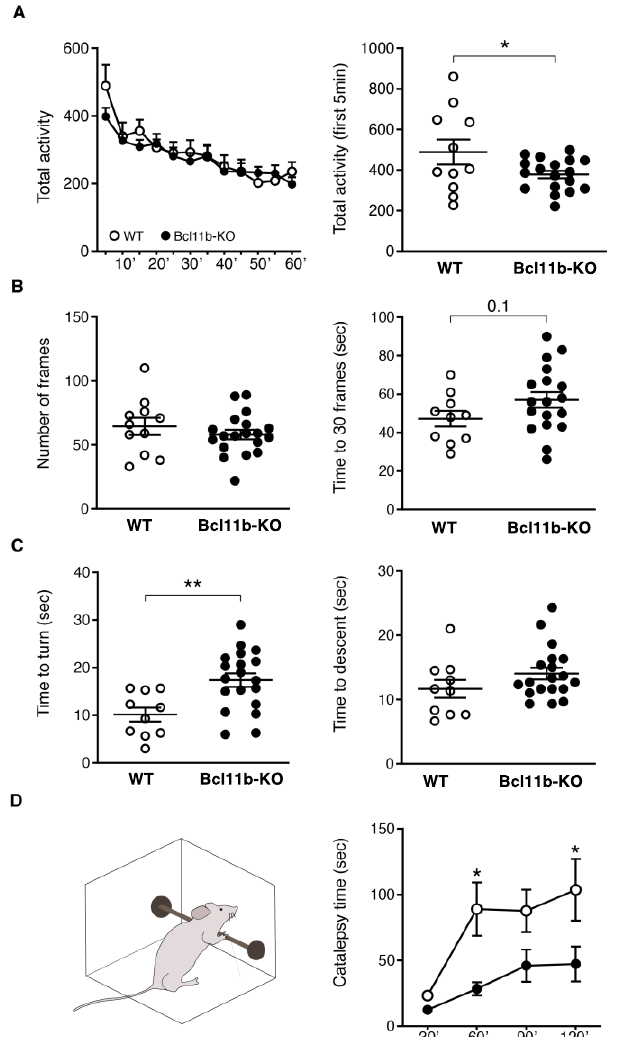
Figure 6. Bcl11b deficiency in adult mice partly recapitulate HD-associated motor phenotype. ( A ). Spontaneous locomotor activity measured in the Bcl11b deficiency mice. ( B ). Balance beam: from left to right ; numbers of frames crossed in 2 min and times to cross 30 frames. ( C ). Vertical pole: times to turn ( left ) and times to descend ( right ) were recorded after placing the mice upwards to the pole. Three trials were conducted, and data represent the mean ± SEM (WT n = 11, D9-Cre-Bcl11b tm1.1Leid mice n = 18). Two-tailed unpaired t -test, * p < 0.05; ** p < 0.01. ( D ). Schematic diagram of catalepsy position (left). Catalepsy time after Haloperidol treatment (right). Two-Way ANOVA, with Bonferroni as post-hoc test * p < 0.05.